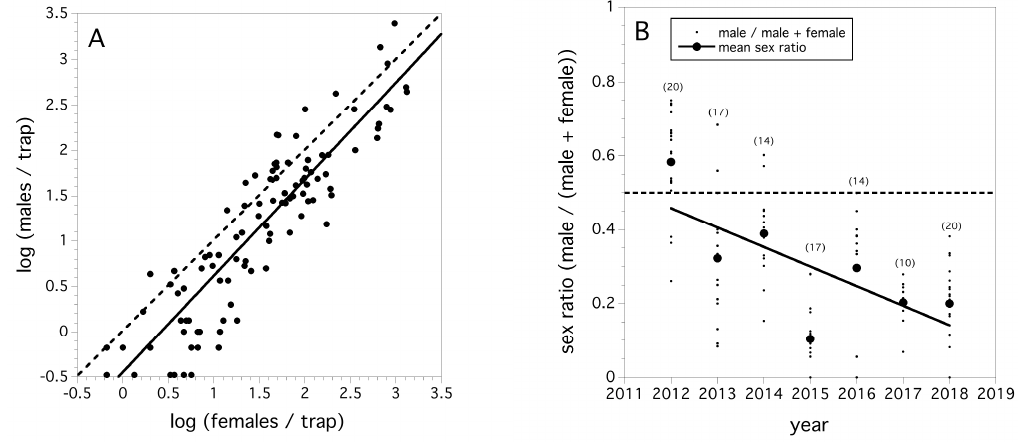
Figure 4. Relationship between male and female trap capture, all fields and all years, solid line is least squares regression fit and dashed line is 50% sex ratio estimate ( A ), and the sex ratio (male: male + female) of total flies captured in each field season by year, small filled circles are individual field sex ratios and large filled circles are mean sex ratios (error bars are standard errors) ( B ).